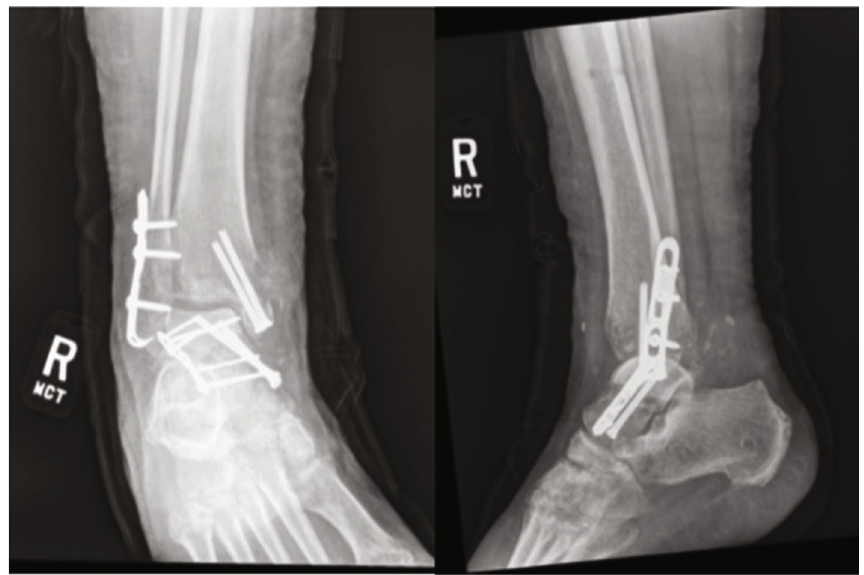
Figure 3: 7-week follow-up; radiographs demonstrated sclerosis of talar dome and body with mild lucency of lateral dome suggestive of potential Hawkins sign.